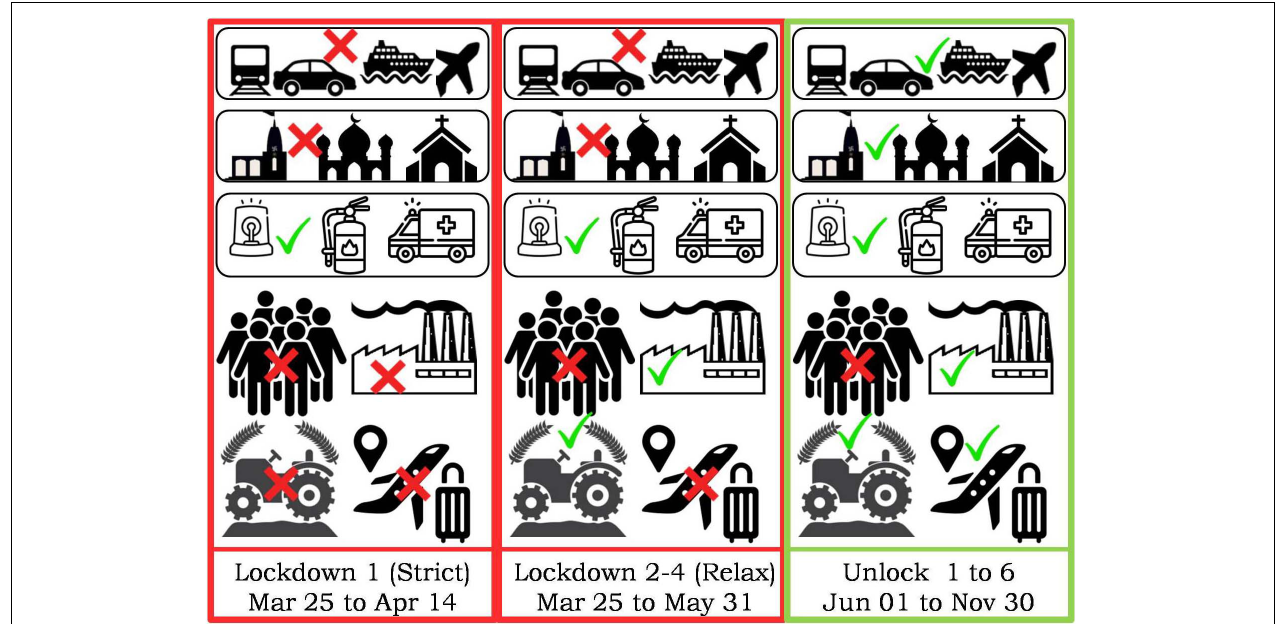
FIGURE 1 | Schematic showing various stages of lockdown and unlock in India during the coronavirus disease 2019 (COVID-19) pandemic.